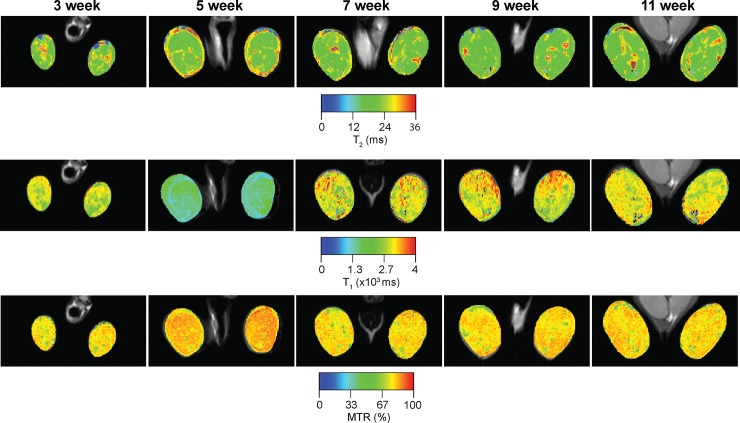
Representative T2, T1, and MTR color maps acquired from lower hind limbs of a mdx4cv mouse followed longitudinally over 11 weeks.The T2, T1 and MTR maps are overlaid onto T2 weighted images to display the change in values for each time point.